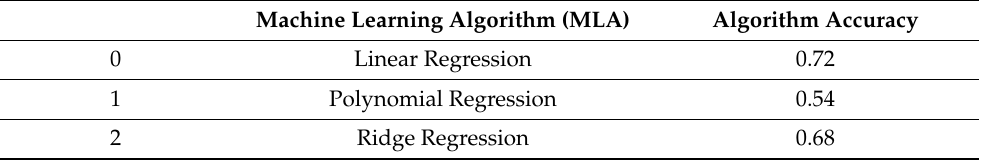
Table 3. Predictive performance of the models used in the